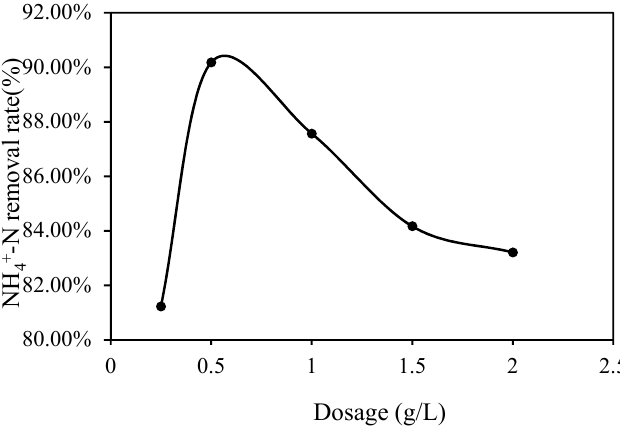
Figure 3. The effect of the Chitin–ZnO dosage on the ammonia nitrogen removal efficiency.